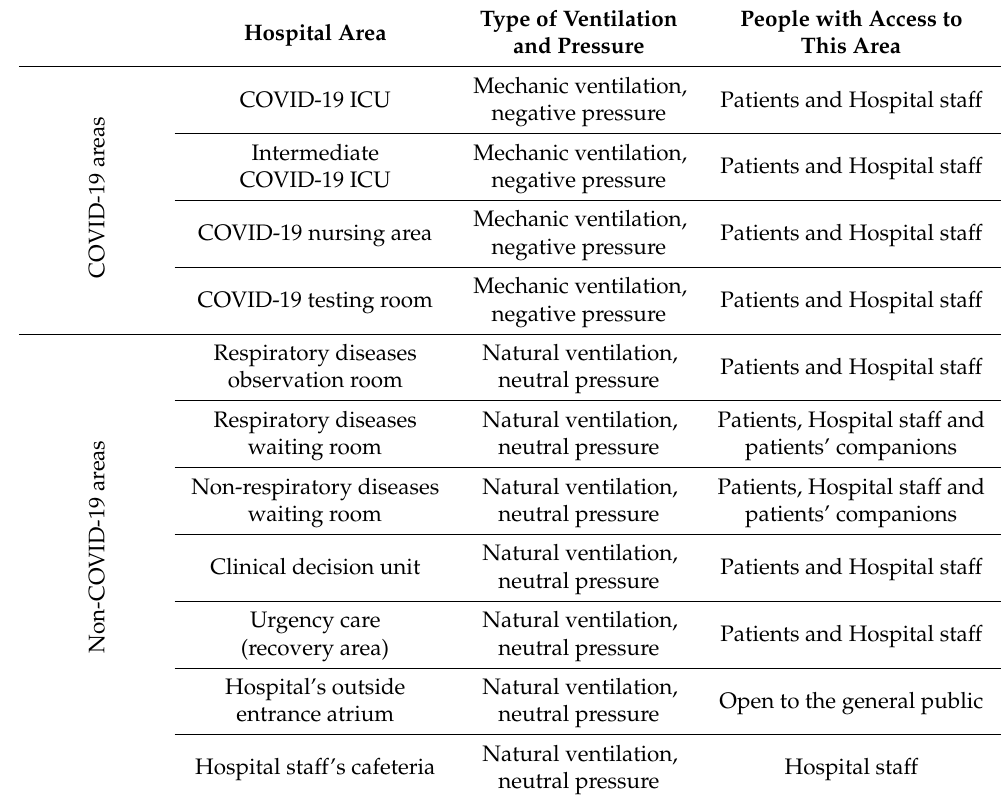
Table 1. Air ventilation details about the sampling sites.